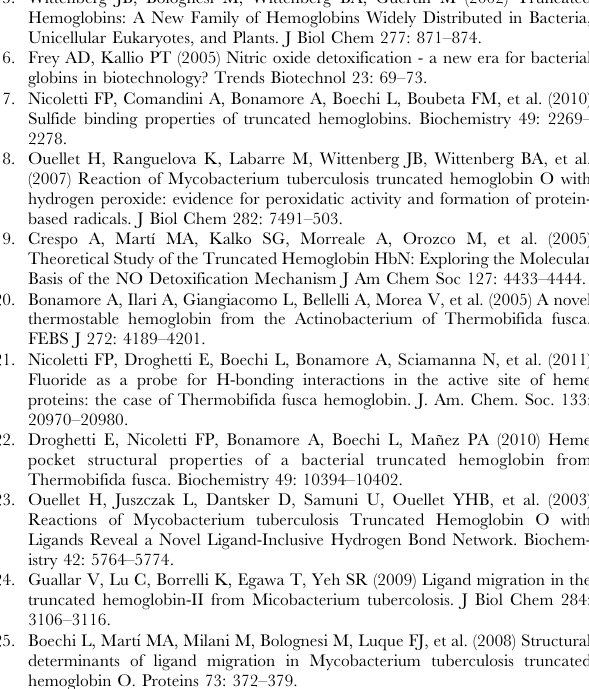
Figure S3 CO rebinding kinetics to Tf -trHb, at 1 atm CO and 10 6 C (black), 15 6 C (red), 20 6 C (green), 25 6 C (blue) and 30 6 C (cyan). Protein concentration was 38 m M. Figure S4 Spectral component ( top , singular value 9.3) and amplitude ( bottom , black open circles) retrieved from the SVD analysis of time resolved spectra collected between 10 ns and 100 ms. The red solid line shows the absorbance change measured at 435 nm. SVD analysis of time resolved difference absorbance spectra collected after nanosecond laser excitation afforded only one statistically meaningful spectral component. The time course of its amplitude closely matches that of the absorbance change at 435 nm showing that this component is monitoring the binding process. The absence of additional spectral components suggest that no significant structural relaxa- tion is occurring at the heme.